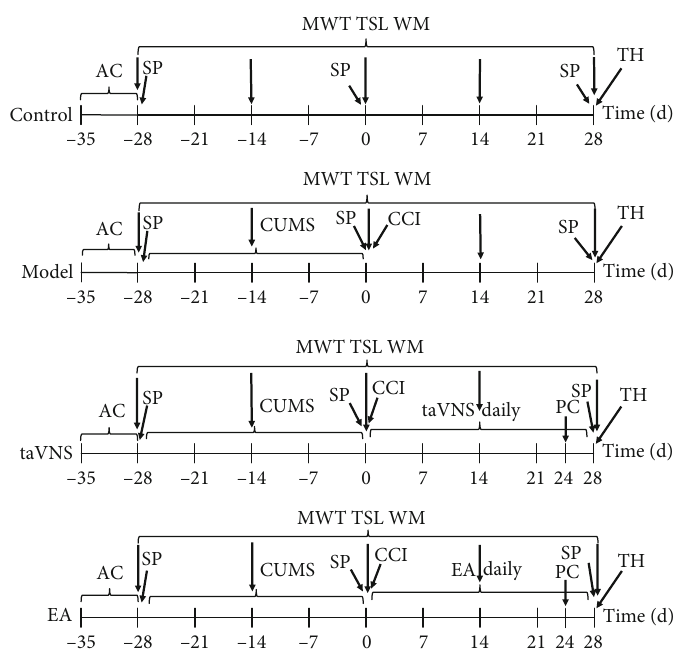
Figure 1: Experimental procedure: AC: acclimatization; SP: sucrose preference; CUMS: chronic unpredictable mild stress; taVNS: transcutaneous vagus nerve stimulation; CCI: chronic constriction injury of the sciatic nerve; MWT: mechanical withdrawal threshold; TSL: thermal stimulation latency; WM: weight measurement; EA: electroaupuncture at ST 36; PC: plasma collection; TH: tissue